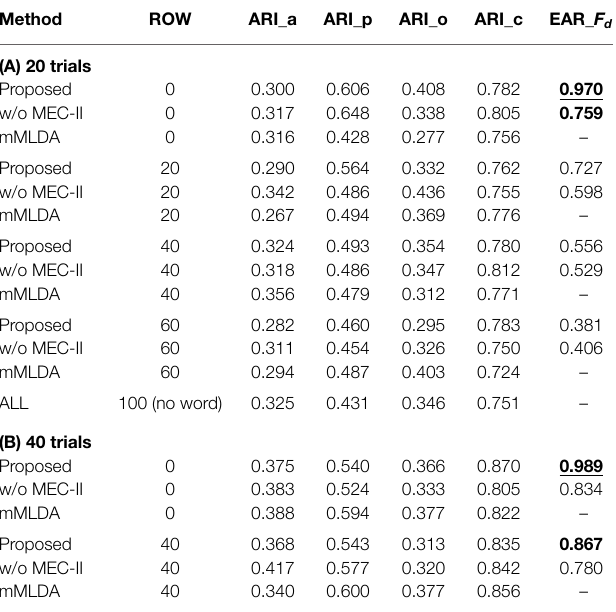
TABLE 1 | Experimental results of the CSL task for 20 and 40 trials. Method